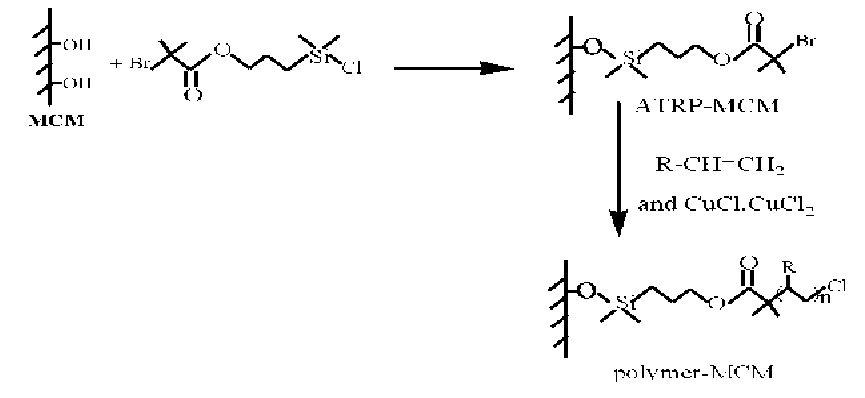
Figure 2. ATRP method for grafting polymer onto the mesoporous silica.